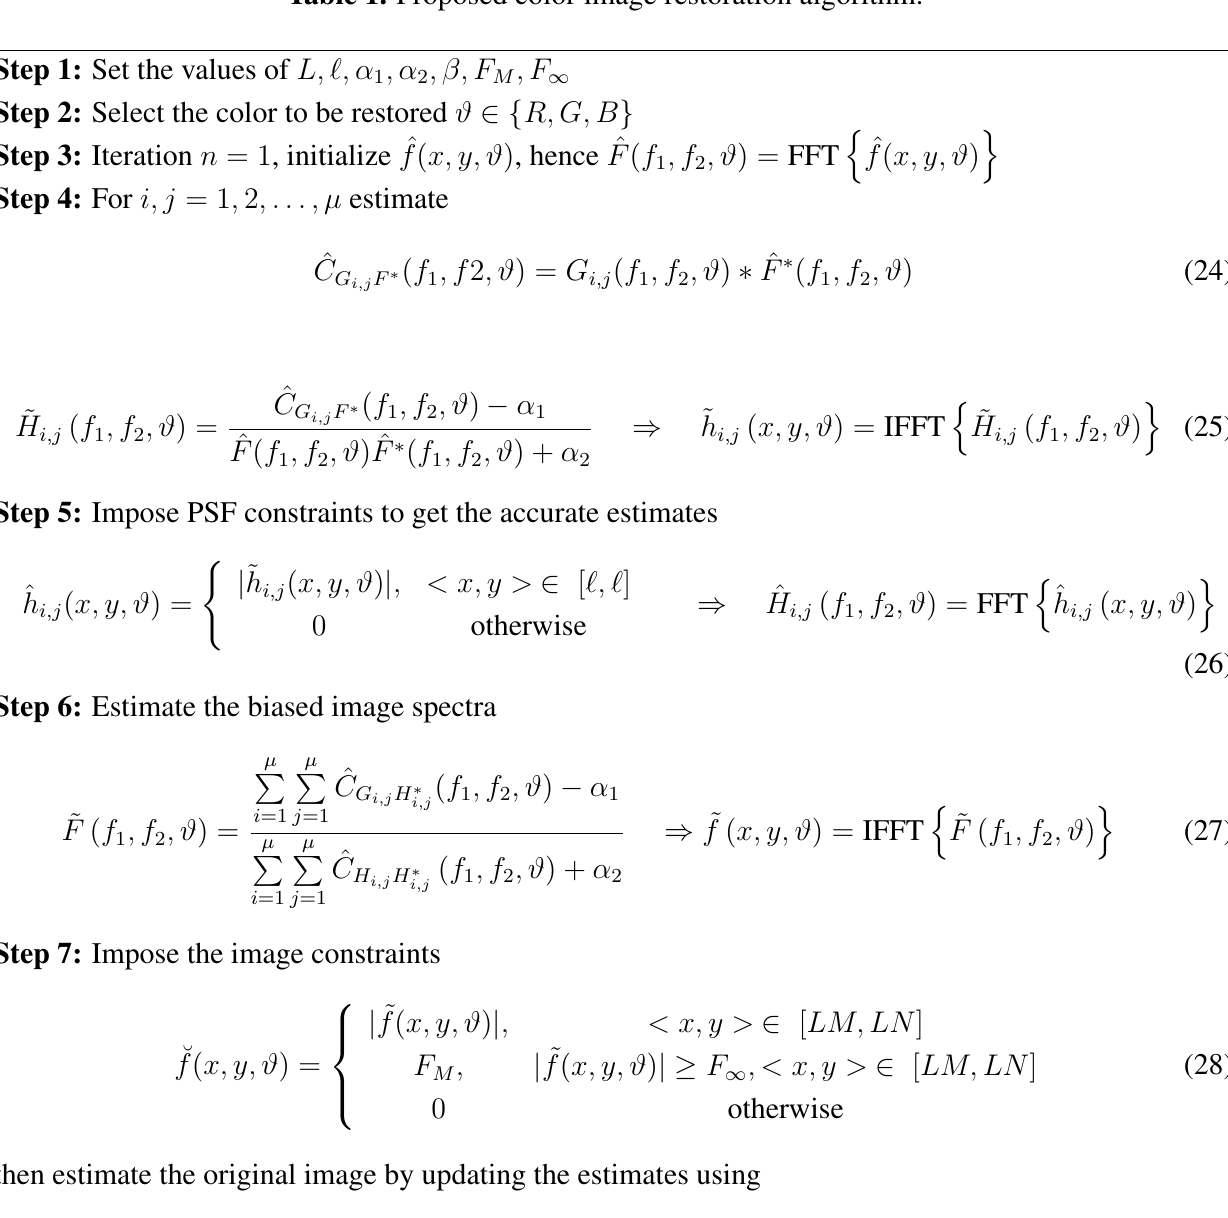
Table 1. Proposed color image restoration